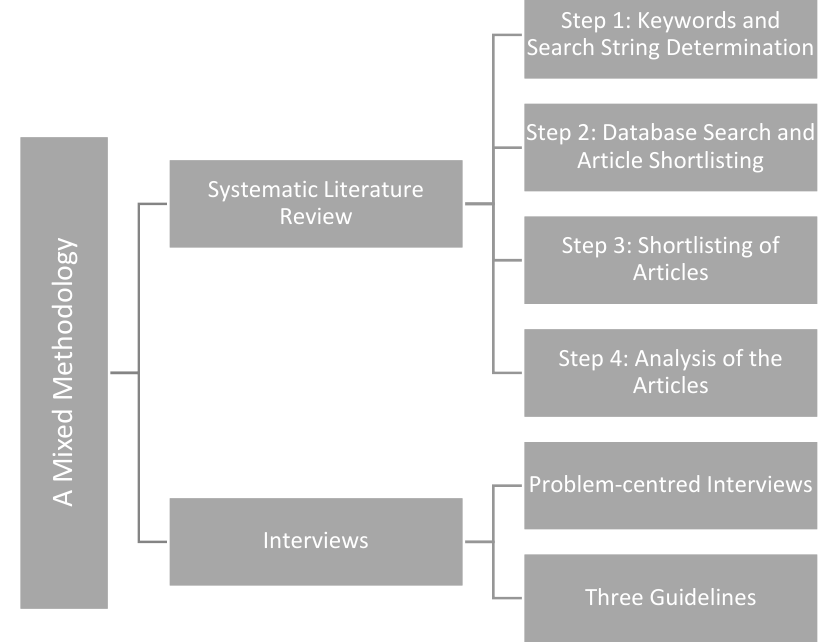
Figure 1. Overview of the mixed methodology.